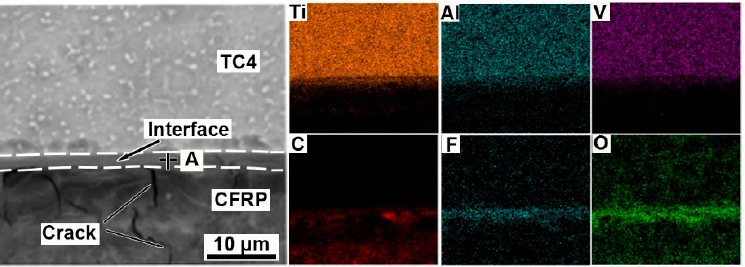
Figure 8. The microstructure of the joint under the power of 550 W and welding speed of 10 mm/s. ( a ) the bonding area appearance; ( b , c , d ) the structures corresponding to the area of B, C, D marked in ( a ).